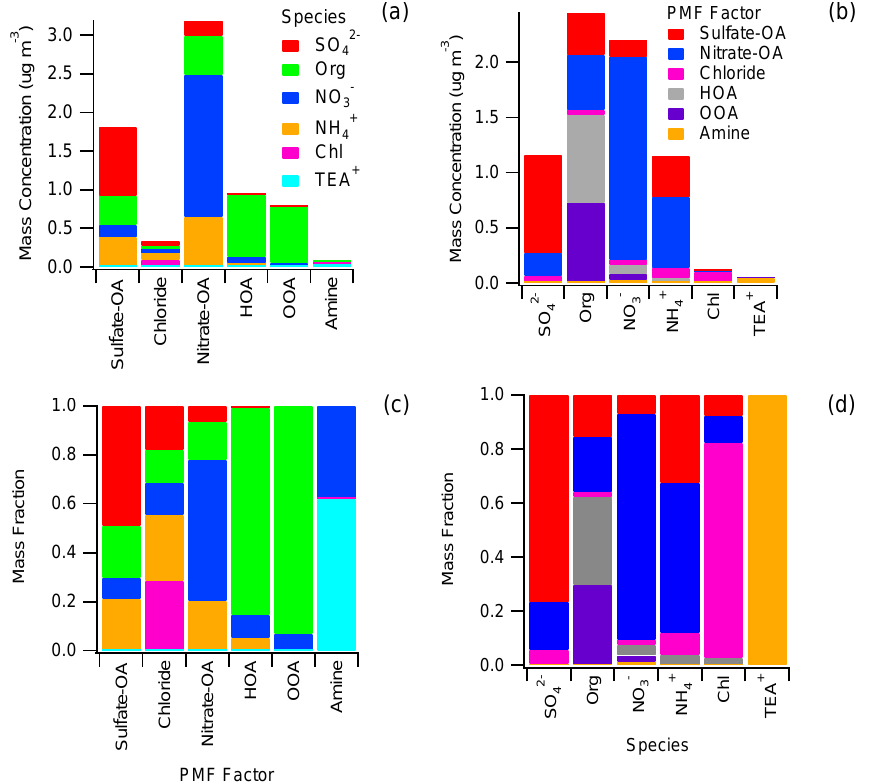
Figure 7. Chemical composition by factor and species components of the six PMF factors from the PMF Full MS